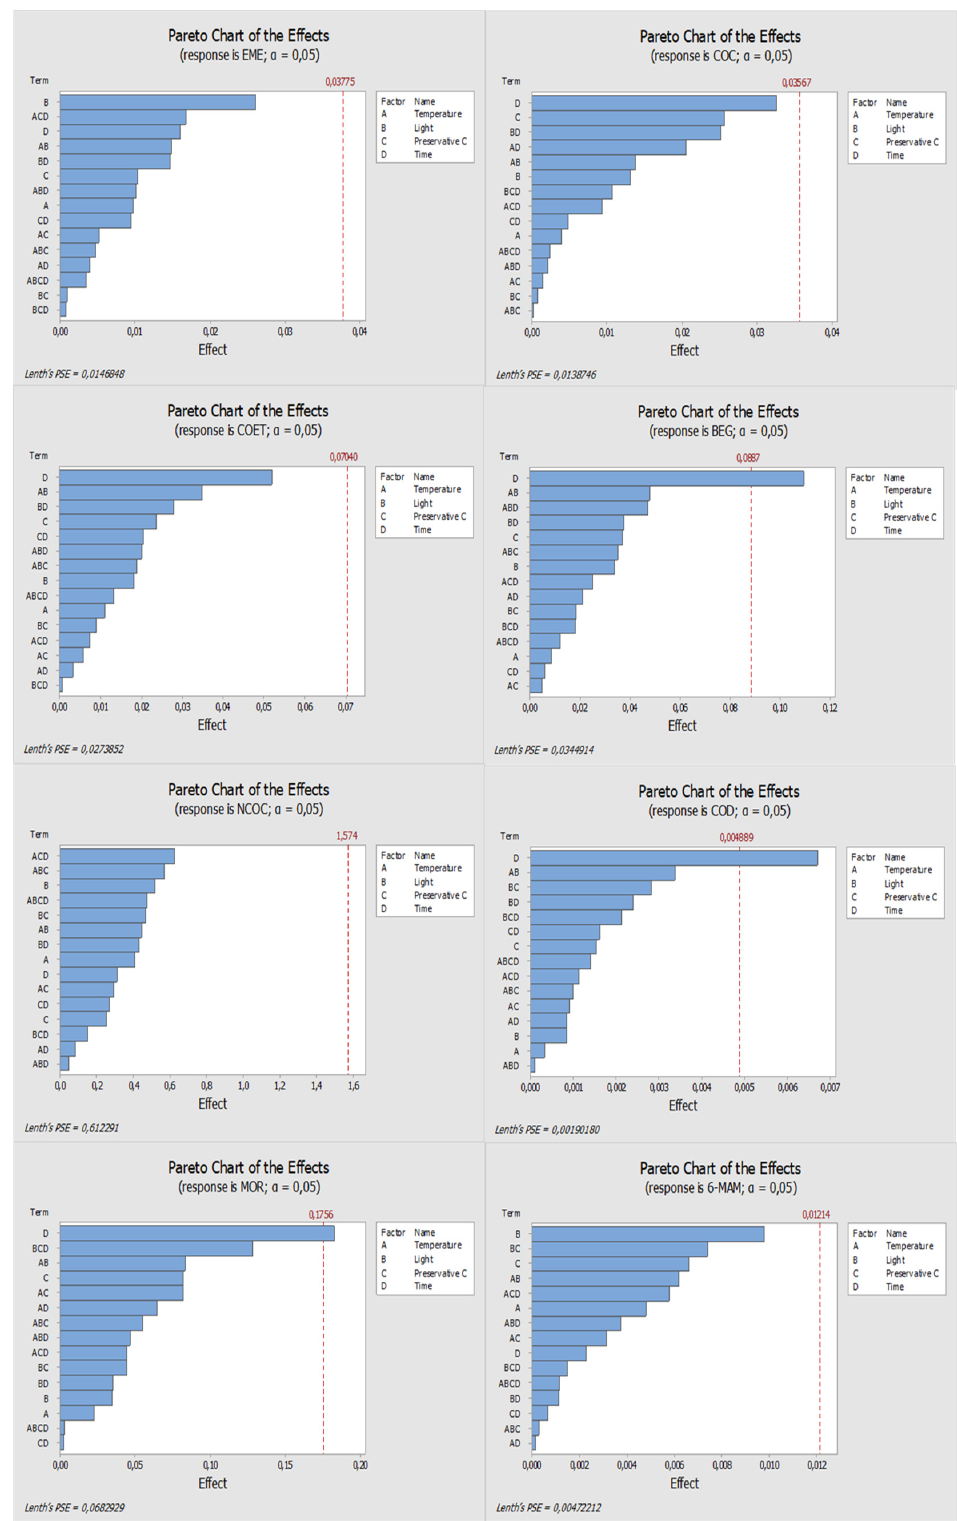
Figure 1. Pareto diagrams of the compounds under study, obtained when ascorbic acid was used as the preservative. The blue bars represent the effects of factors or a combination of factors: A— Temperature, B—Light, C—Preservative, and